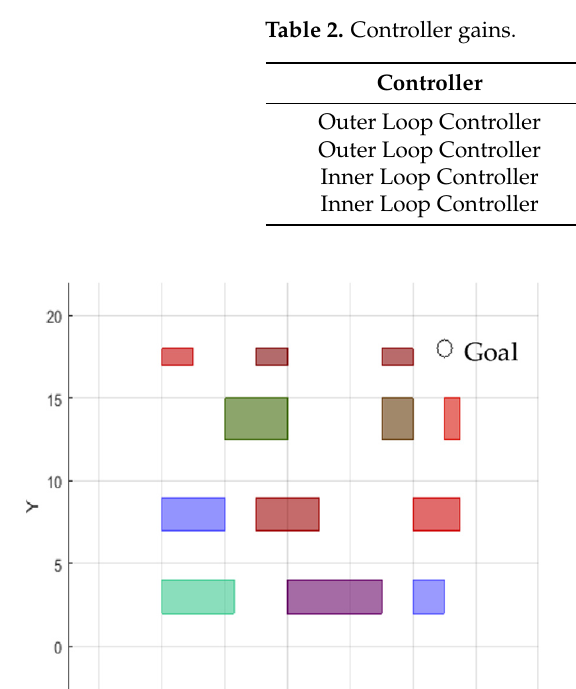
Figure 6. Augmented A* search in progress through the meshed environment (2D and 3D views).